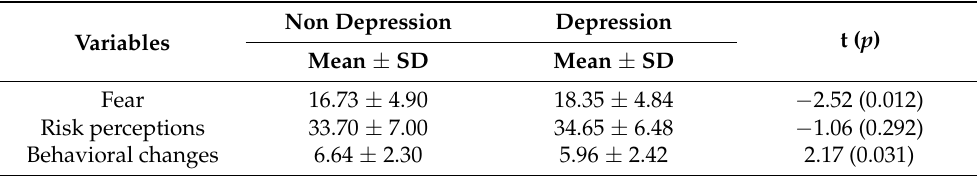
Table 2. Comparison of fear, risk perceptions, and behavioral changes between the two